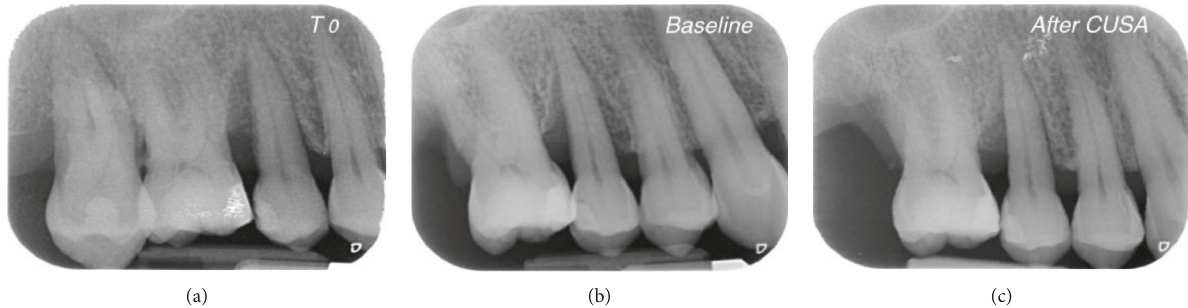
Figure 8: Progression of X-rays showing bone remineralization. Baseline is 12 months after (a) T0. In this case, the PD decreased from 9mm ((b) baseline) to 4 mm (6 months (c) after CUSA). The CAL gain was 6 mm (from 15mm to 9mm).